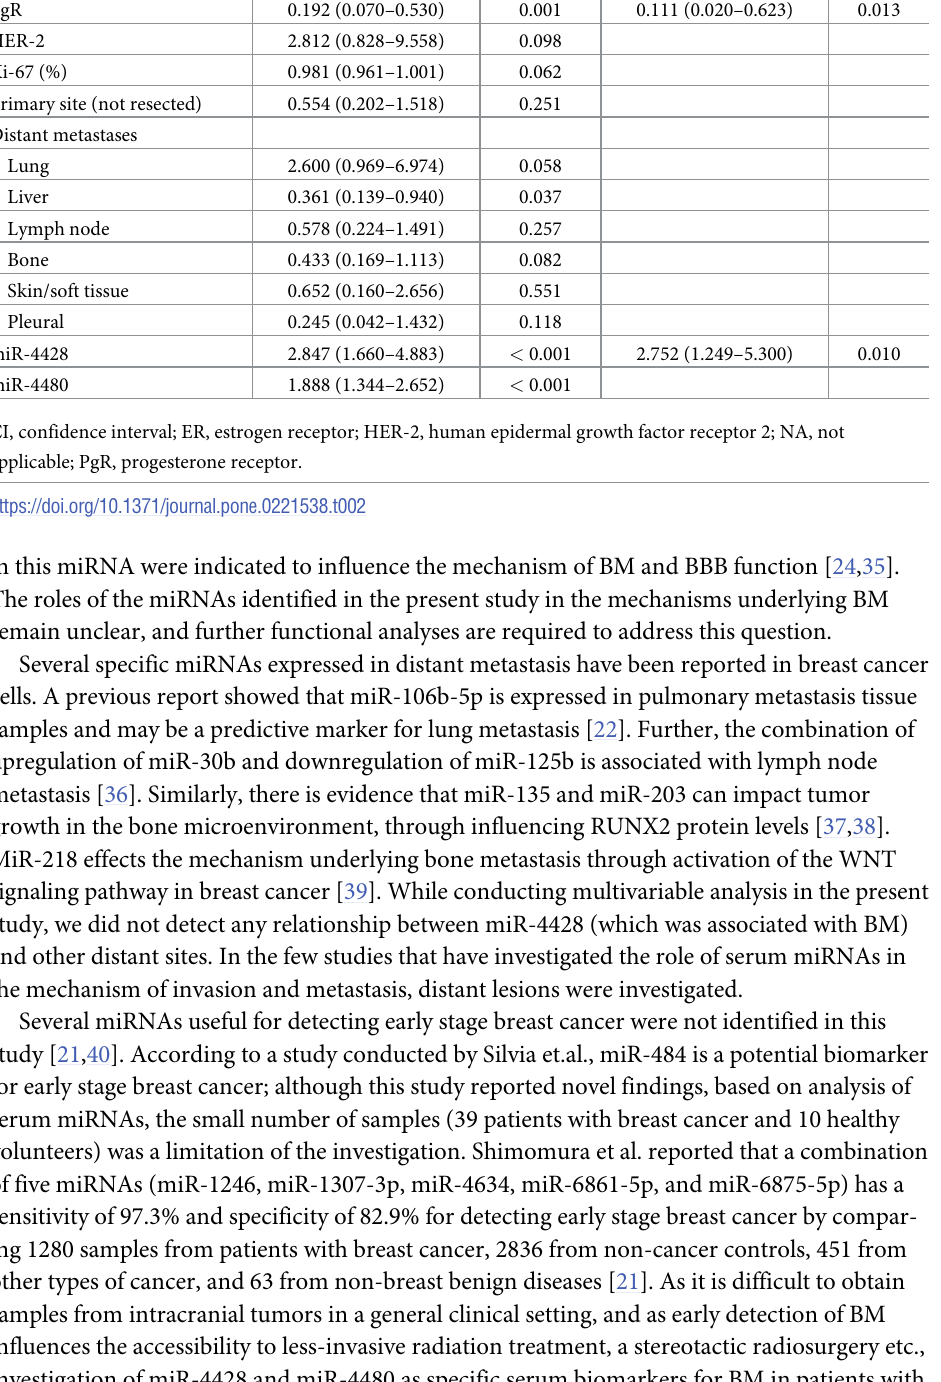
Table 2. Results of multivariable analysis.